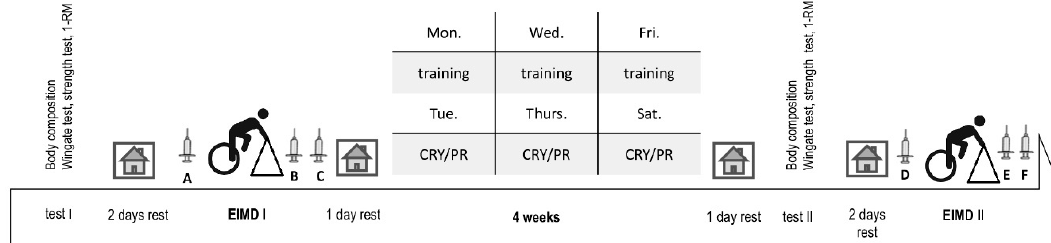
Figure 1. The schedule of the experiment.